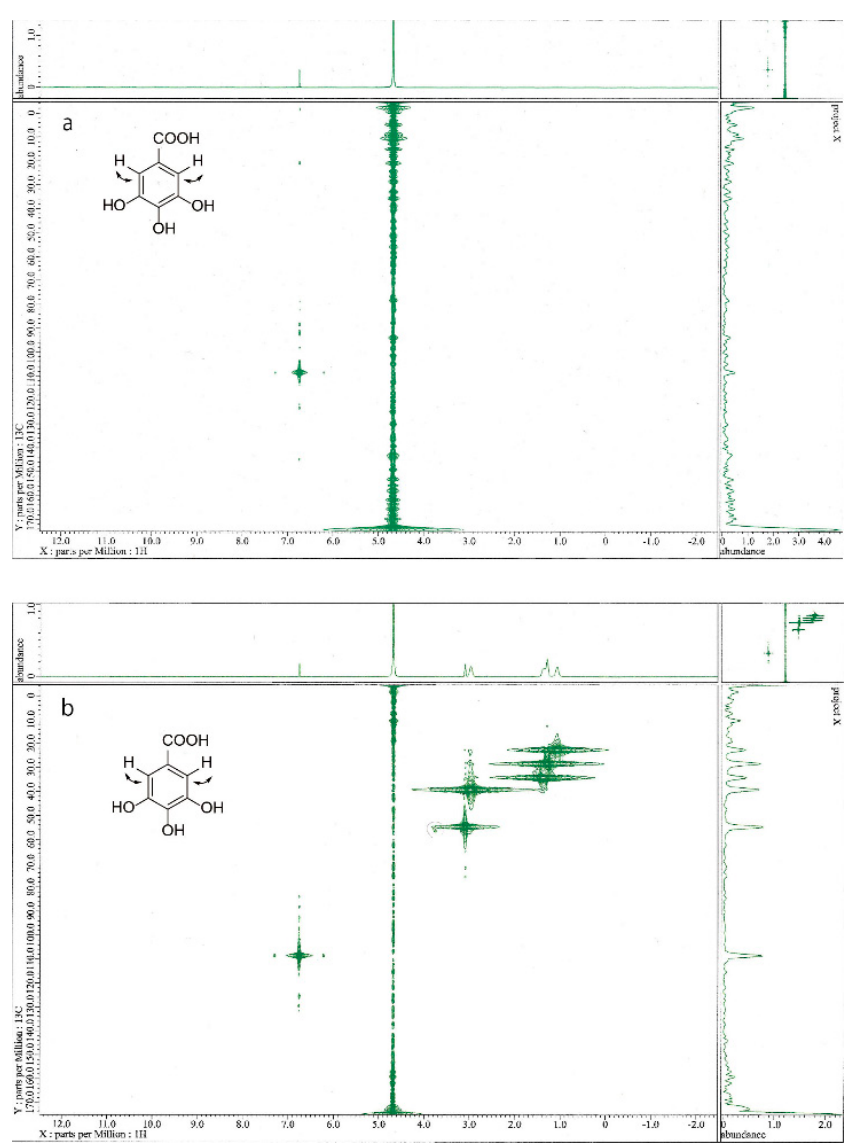
Figure 1. HMQC spectra of gallic acid ( a ) and gallic acid–EPL complex ( b ).